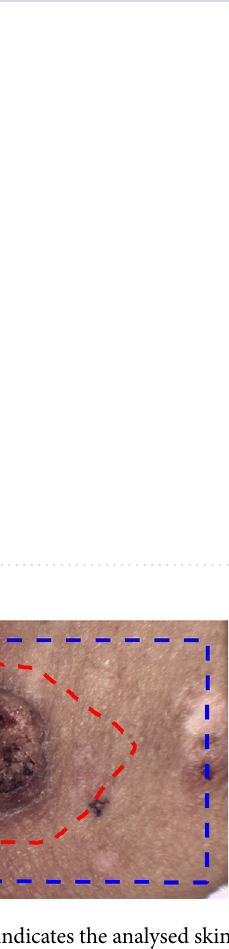
Figure 1. Example of masks. Blue line indicates the analysed skin area and the red line indicates the biopsy mask. The dots for image registration can be seen on both sides of the